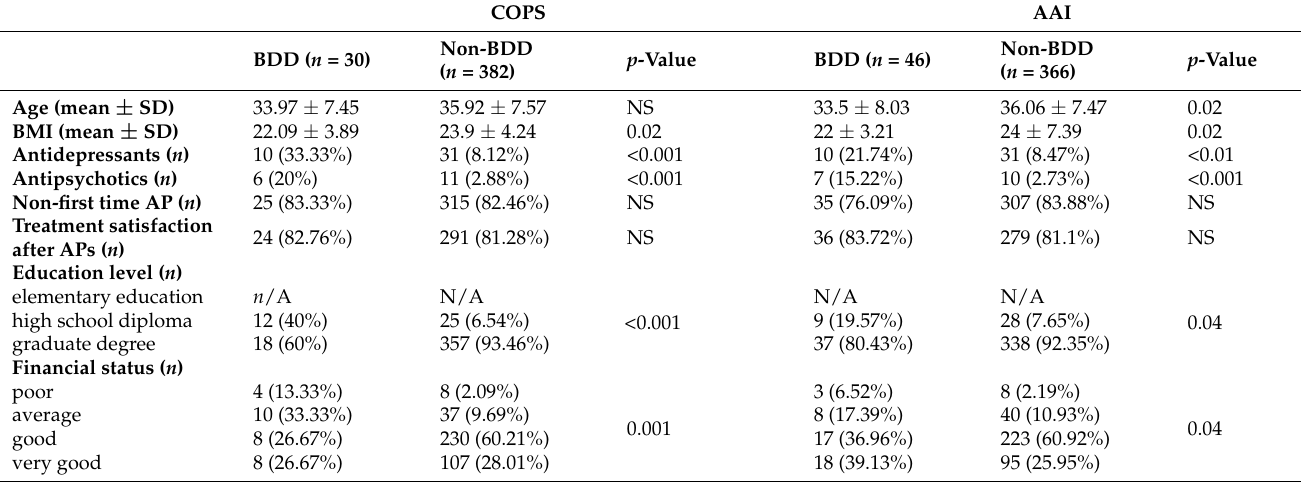
Table 2. Characteristics of the BDD and non-BDD groups that were undergoing aesthetic dermatology procedures, according to different screening